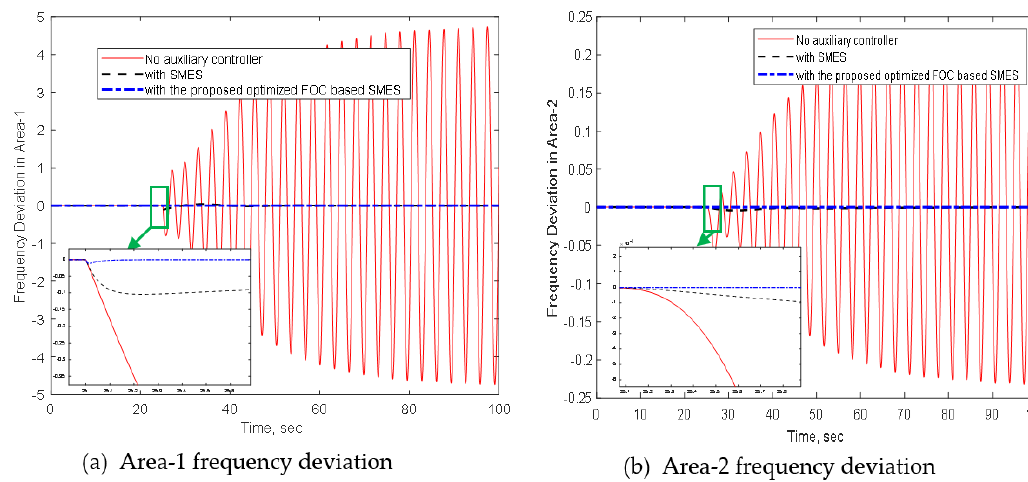
Figure 9. Frequency response for 0.3 p.u. load change in area-1.